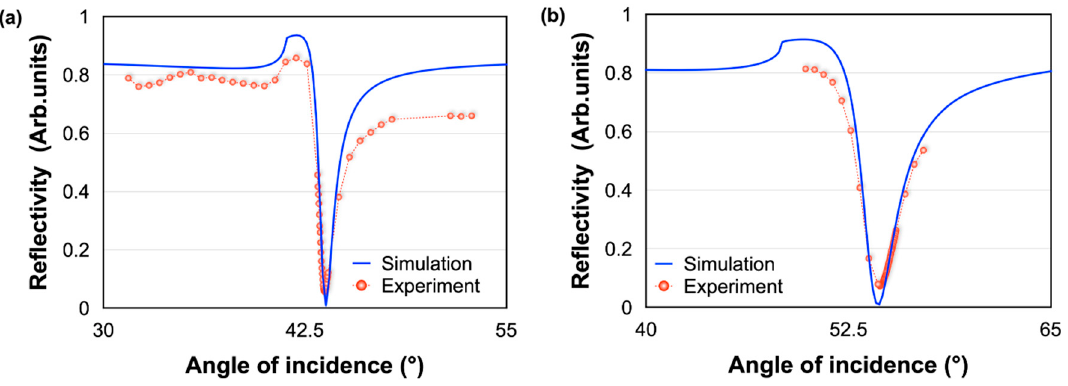
Figure 5. Reflectivity spectra measurement with prism–Au substrate with ( a ) air and ( b ) water in the sensing cell.